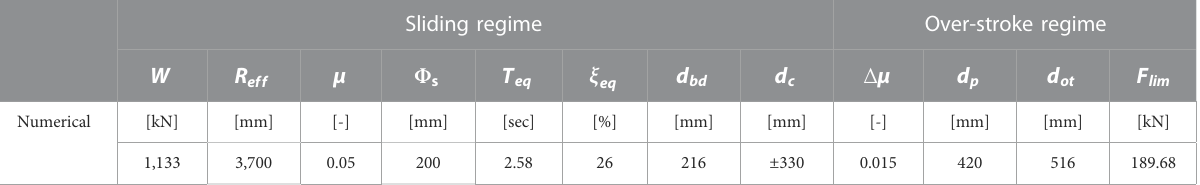
TABLE 2 Main characteristics of the DCCSS for the case study.